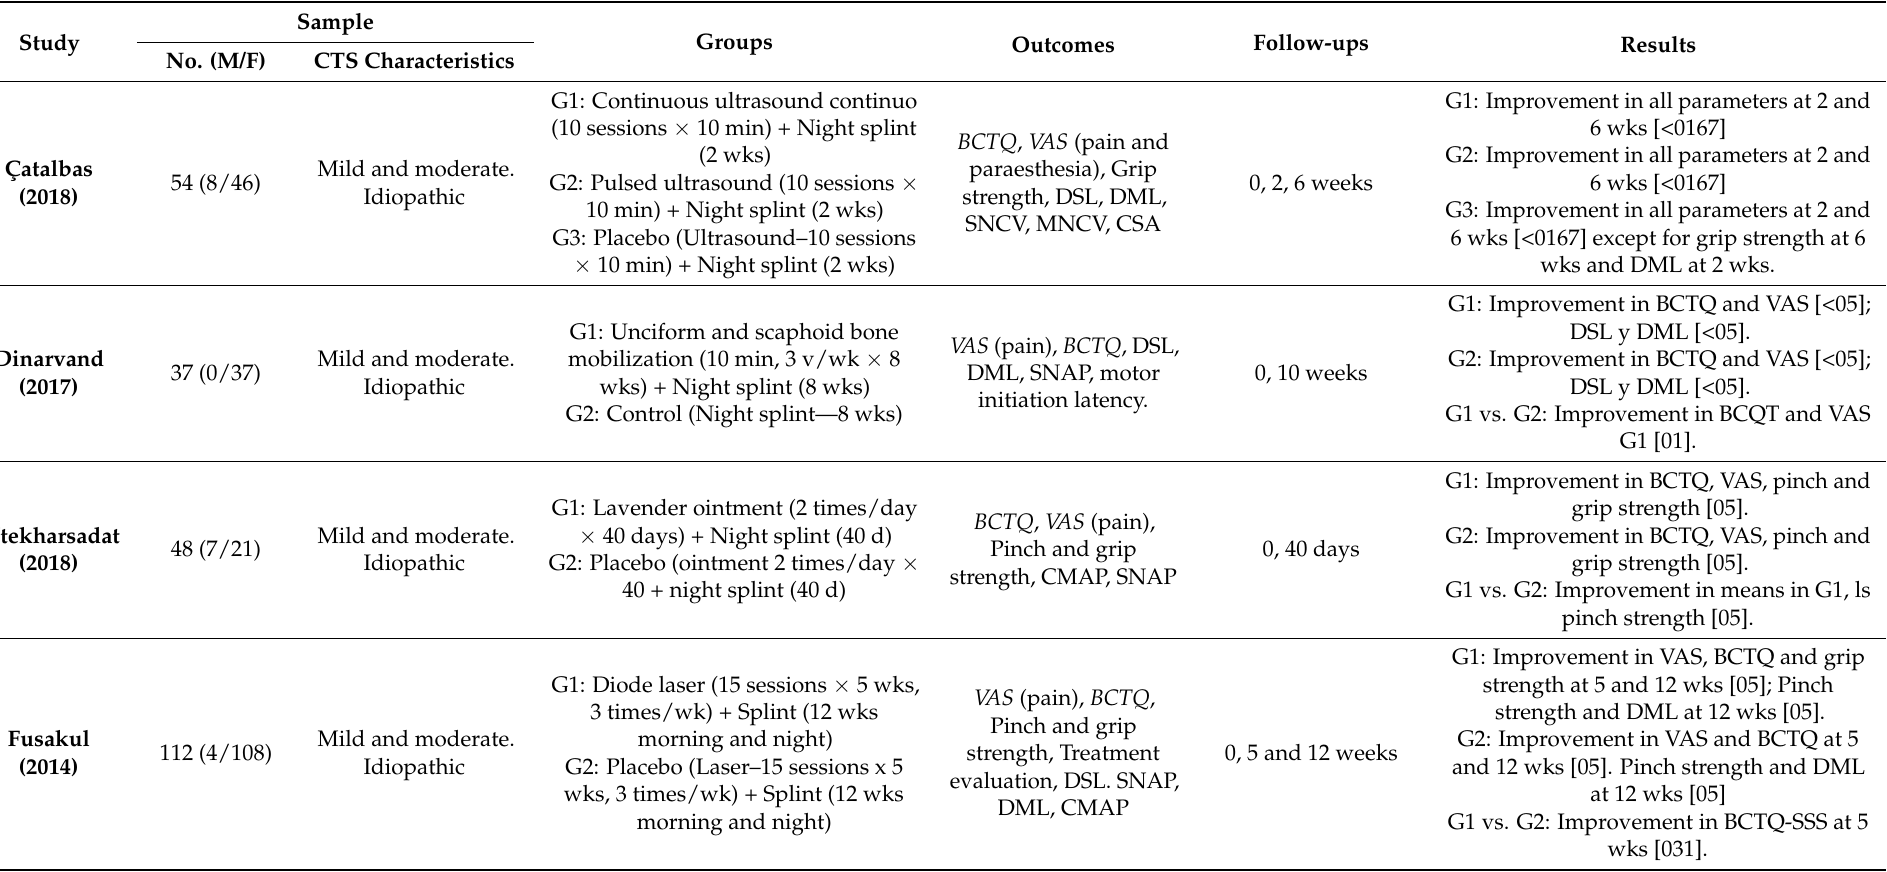
Table 2. Characteristics of Studies: Mild and Moderate